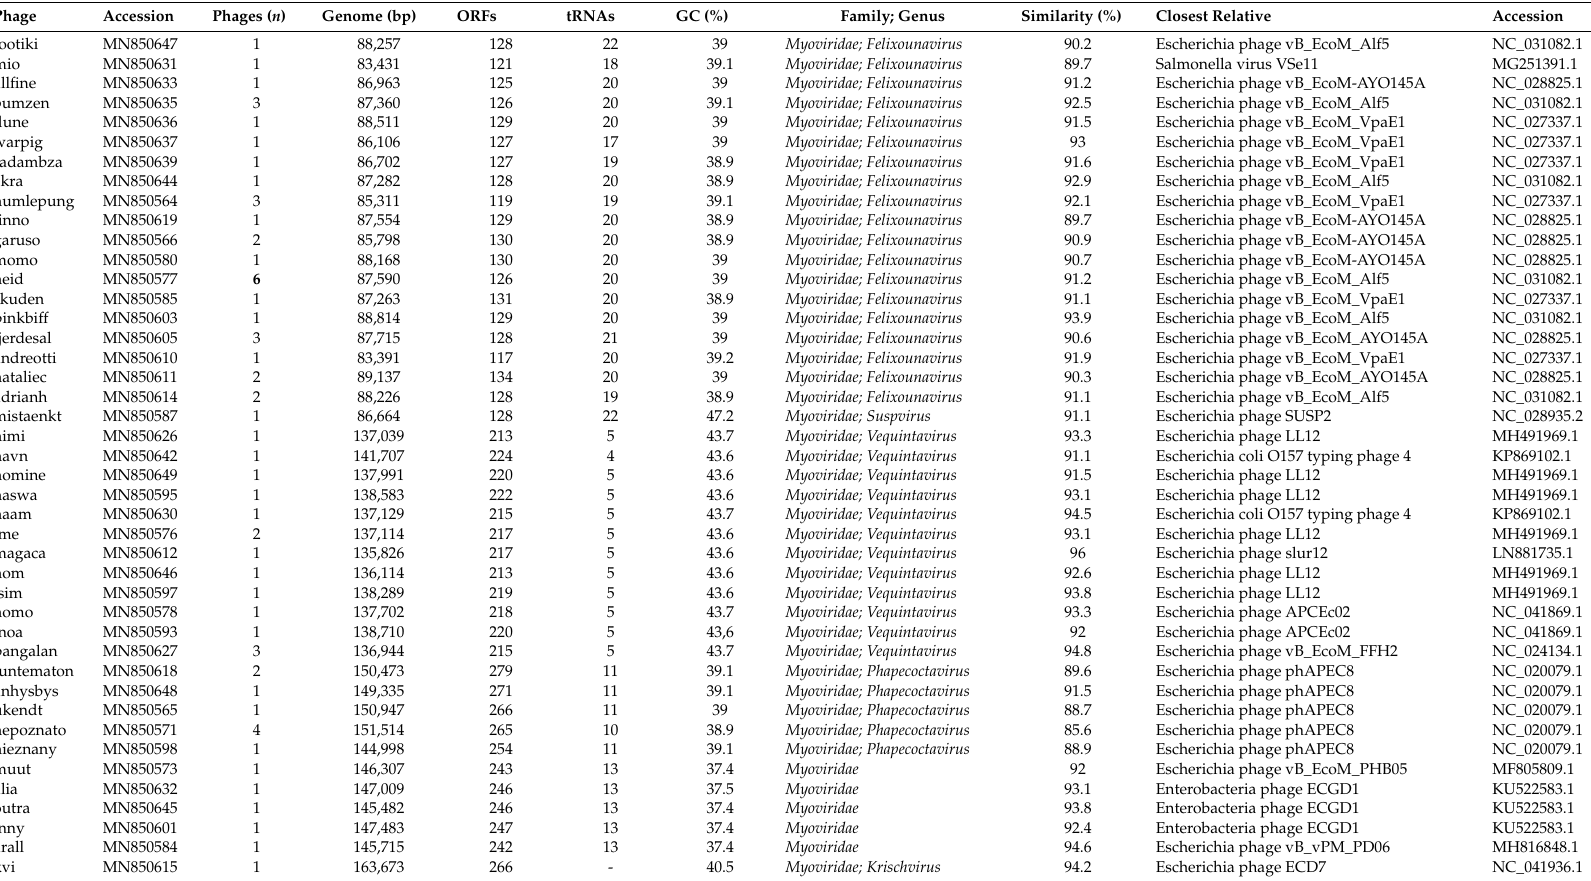
Table 1. List of 104 unique Escherichia phage species identified in 94 Danish wastewater samples. Phages ( n ) denotes the number of phages isolated with more than 95% nucleotide sequence similarity. Similarity is sequence identity (%) times sequence coverage (%) to closest relative (Blastn). Taxonomy is based on similarity (BLASTn) to closest